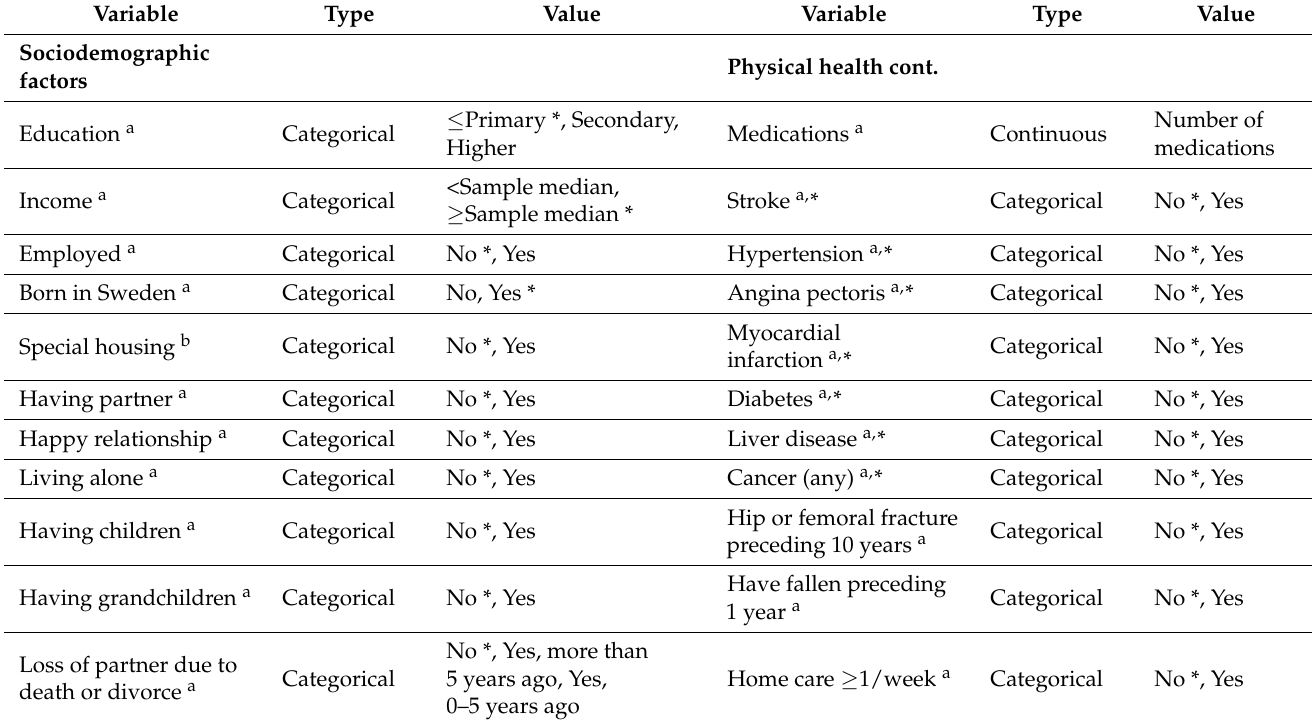
Table 1. Categorization of included variables; type, values, and collection